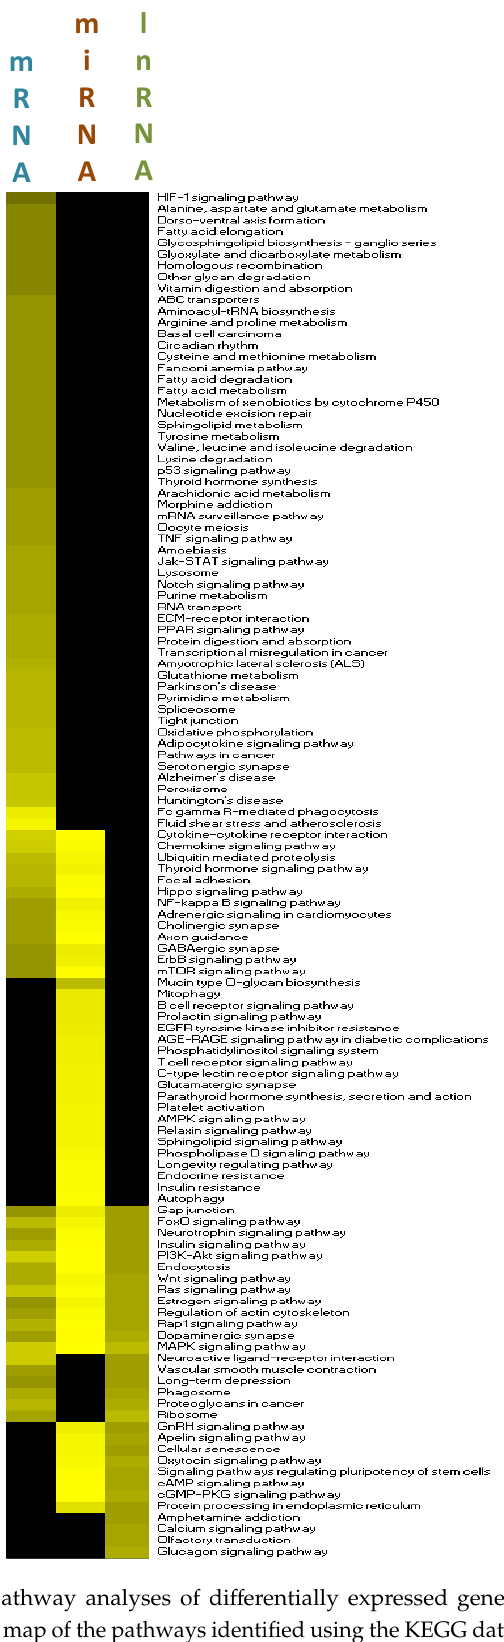
Figure 7. Heatmap of pathway analyses of di ff erentially expressed genes, miRNA target genes, and lncRNA targets. Heat map of the pathways identified using the KEGG database using di ff erentially expressed genes, target genes of di ff erentially expressed miRNA, and targets of lncRNA. The color intensity is proportional to the number of genes in the